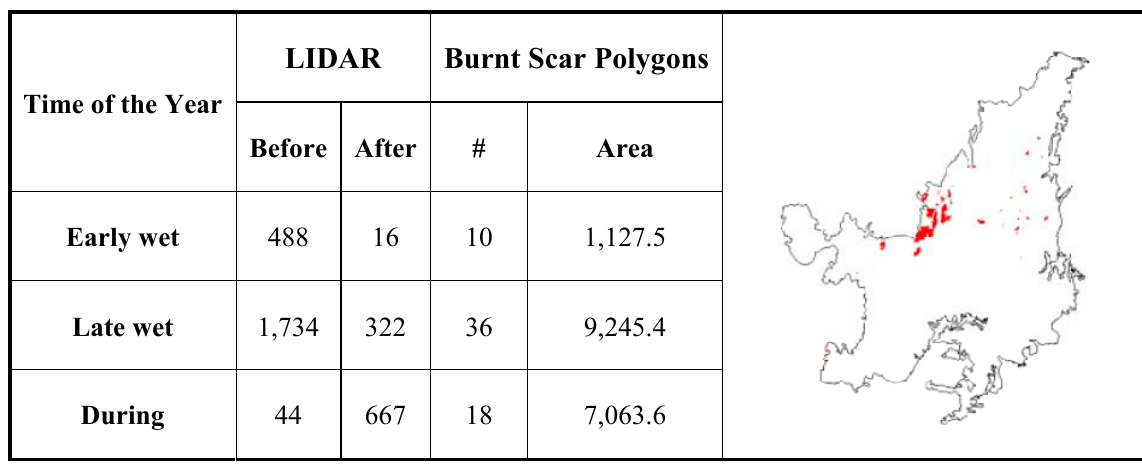
Table 6. Number of LIDAR points over burnt scars in the Cerrado (2007), organized in before and after groups and according to the three main observation periods (inset figure shows the spatial distribution of all burnt scars with before-after LIDAR